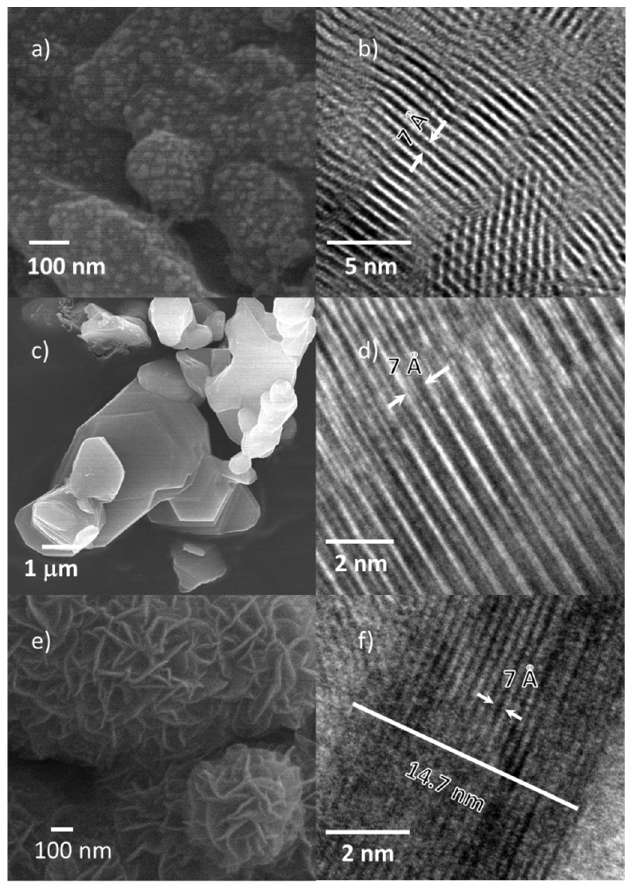
Figure 4. SEM ( left ) and HRTEM ( right ) representative images of ( a , b ) KMn4, ( c , d ) KMn8, and ( e , f ) HKMn.